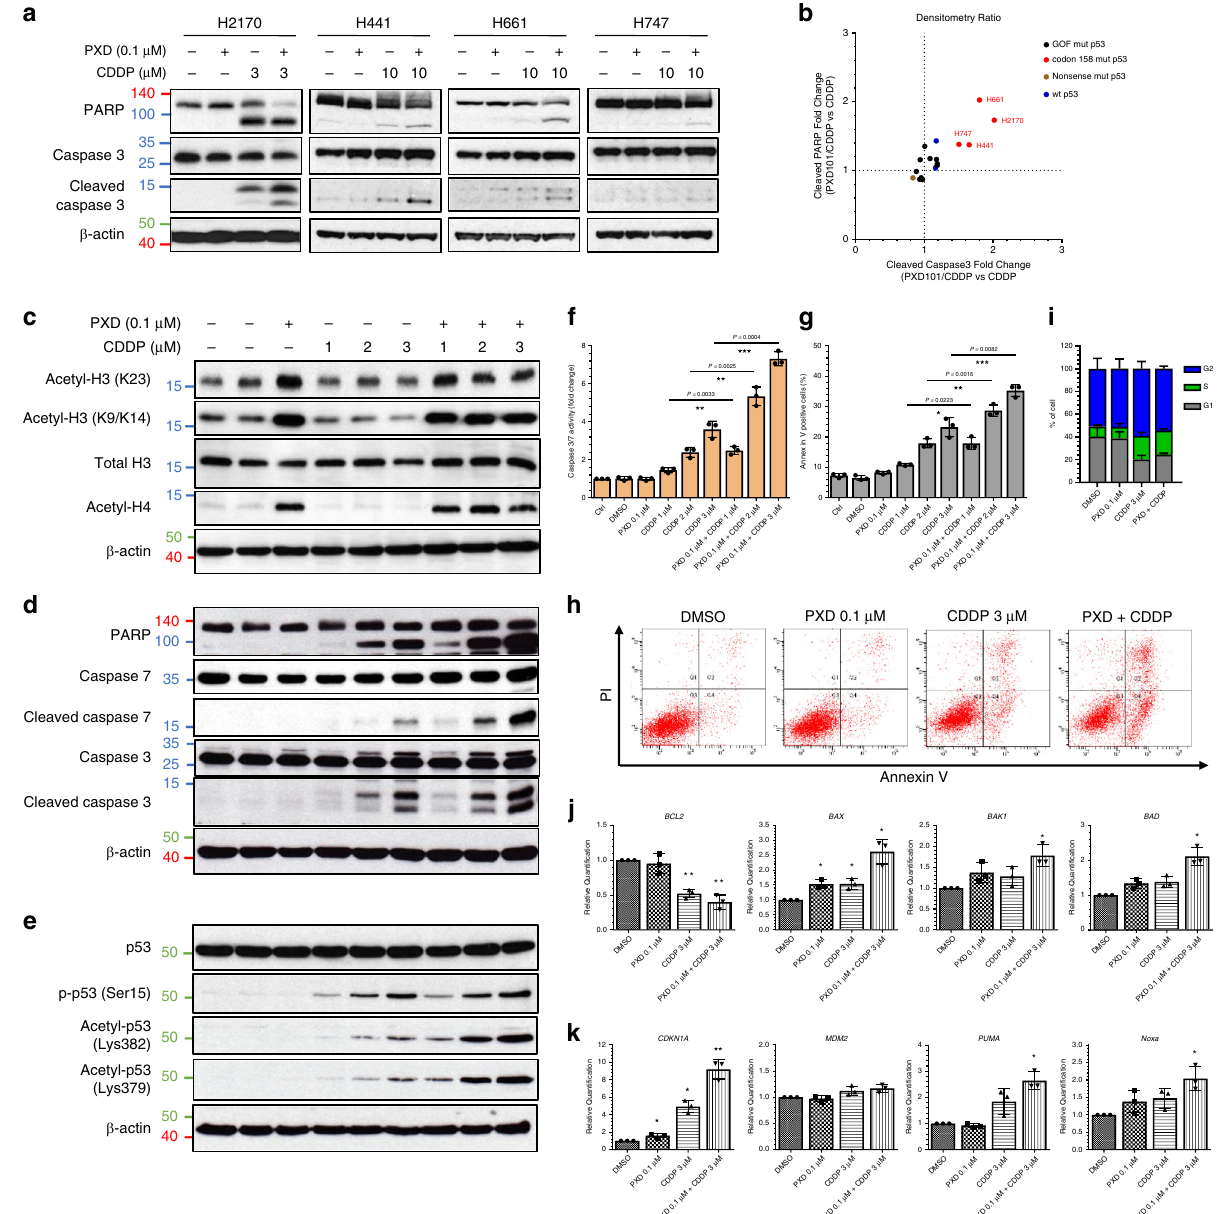
Fig. 3 Synergistic cytotoxicity of cisplatin and belinostat in carcinoma cells with Arg 158 mutp53 status. a Western blot measuring the changes in PARP and caspase-3 in Arg 158 mutp53 cells (H2170, H441, H661, and H747) after 48 h treatment with belinostat (PXD101; 0.1 μ M) and cisplatin (CDDP; 3 or 10 μ M). β -actin shown as loading control ( n = 3 independent experiments). b Densitometry of cleaved PARP ( x -axis) and caspase 3 ( y -axis), respectively, for blots in Fig. 3a and Supplementary Fig. 3A, B. Data was quanti fi ed and normalized to β -actin, tabulated as ratio of belinostat/cisplatin combination to cisplatin alone ( b ). Data are represented as mean of three independent experiments. c – e H2170 cells were treated with increasing concentrations of cisplatin (1, 2, 3 μ M) in combination with belinostat (0.1 μ M) for 48 h. Western blot indicating the changes in endogenous histones ( c ), apoptotic markers ( d ), and post-translational modi fi cations of p53 ( e ). β -actin shown as loading control ( n = 3 independent experiments). f – i Effects of the indicated treatments on caspase 3/7 activation ( f ), apoptosis (Annexin V staining) ( g , h ) and cell cycle (PI staining) ( i ) were quanti fi ed after 48 h. Data are represented as mean ± SD ( n = 3 independent experiments). Two tailed Student ’ s t -test; * P < 0.05, ** P < 0.01, *** P < 0.001. j – k RT-qPCR analyses of the changes in mRNA levels of apoptotic markers ( BCL2 , BAX , BAK1 , BAD ) ( j ) and p53 downstream targets ( CDKN1A , MDM2 , PUMA , PMAIP1 ) ( k ) in H2170 cells 48 h post-treatment. Data are represented as mean ± SD ( n = 3 independent experiments). Two tailed Student ’ s t -test; * P < 0.05, ** P <